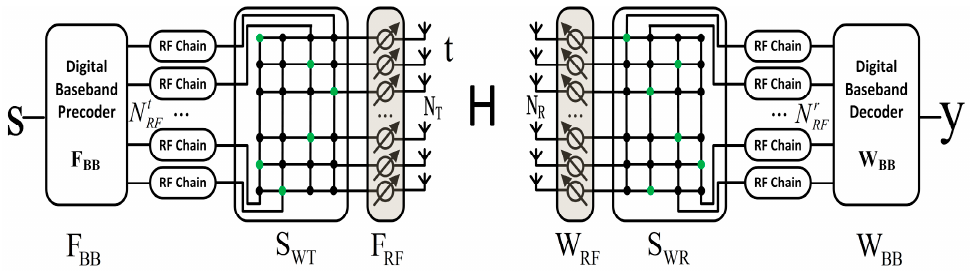
Figure 3. Hybrid precoding unit structure base on a switching network (the green connection node of the switching network represents the on-state, and black represents the off-state.).